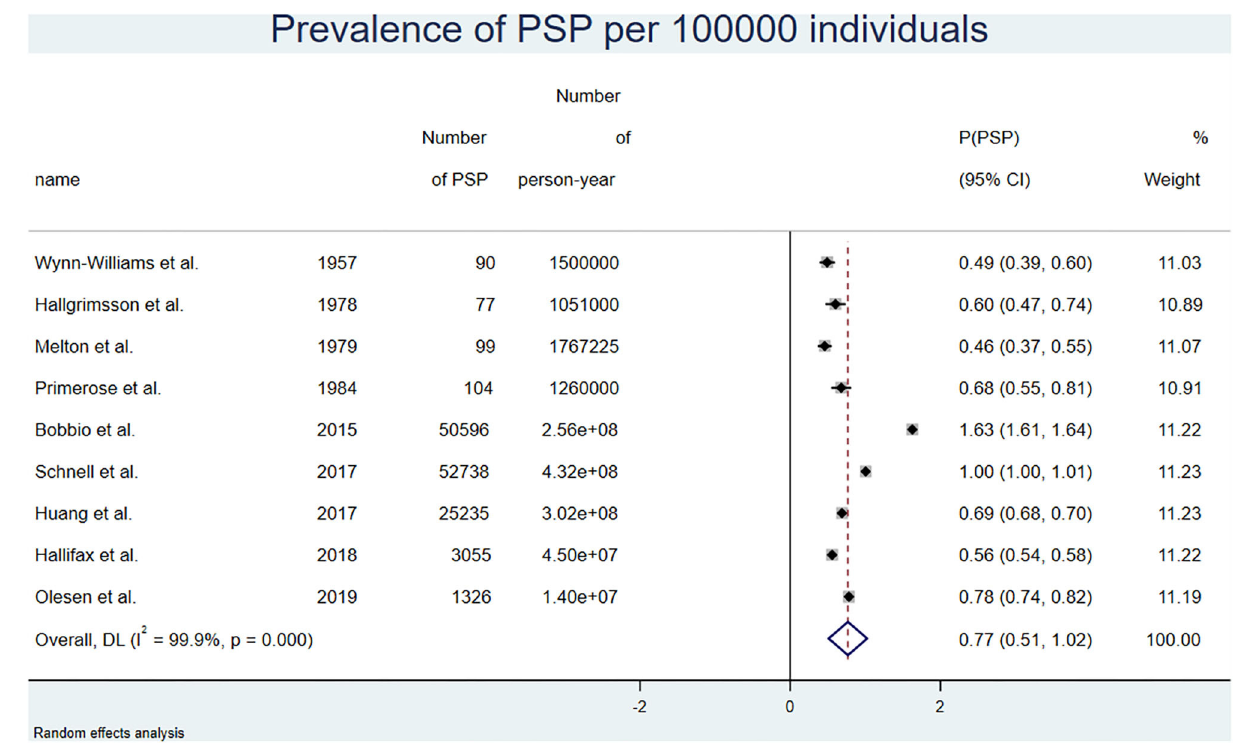
FIGURE 3 | Forest plot of the overall prevalence of pneumothorax for 100,000 person-years corrected for relapses, random-effects